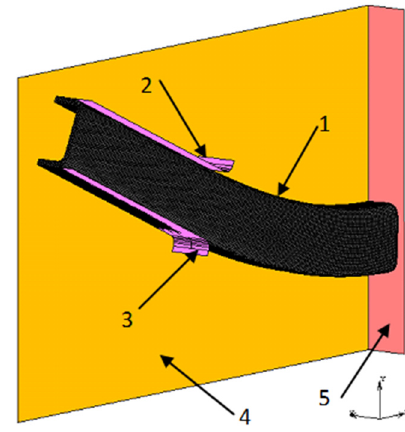
Figure 6. 3D model of the analyzed bending process: 1, bent beam with a fine element (FE) mesh; 2 and 3, surfaces of the clamping jaw; 4 and 5, longitudinal and transverse symmetry planes.